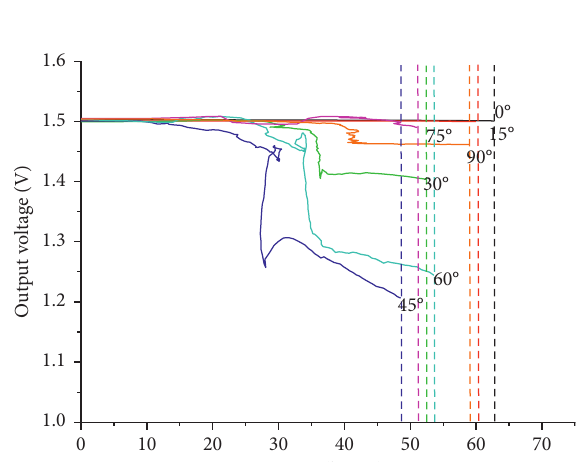
Figure 11: Output